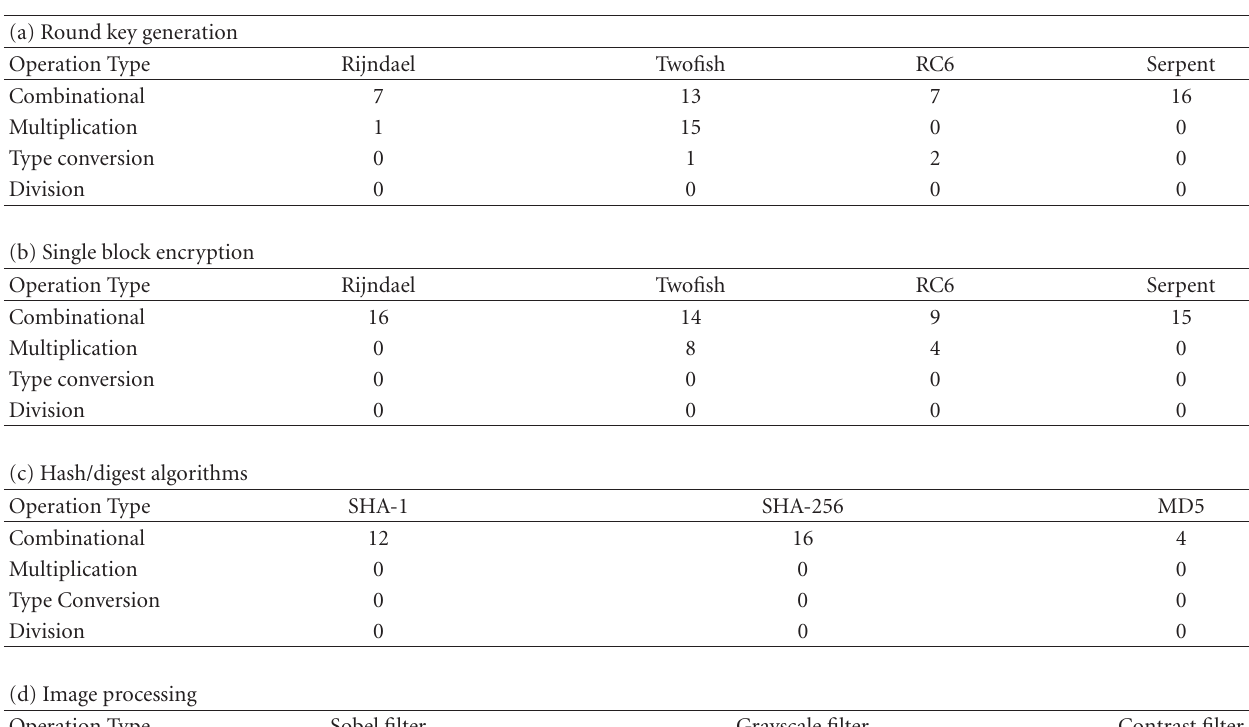
Table 5: Largest number of equal operation types executed within a single state on an array with 16